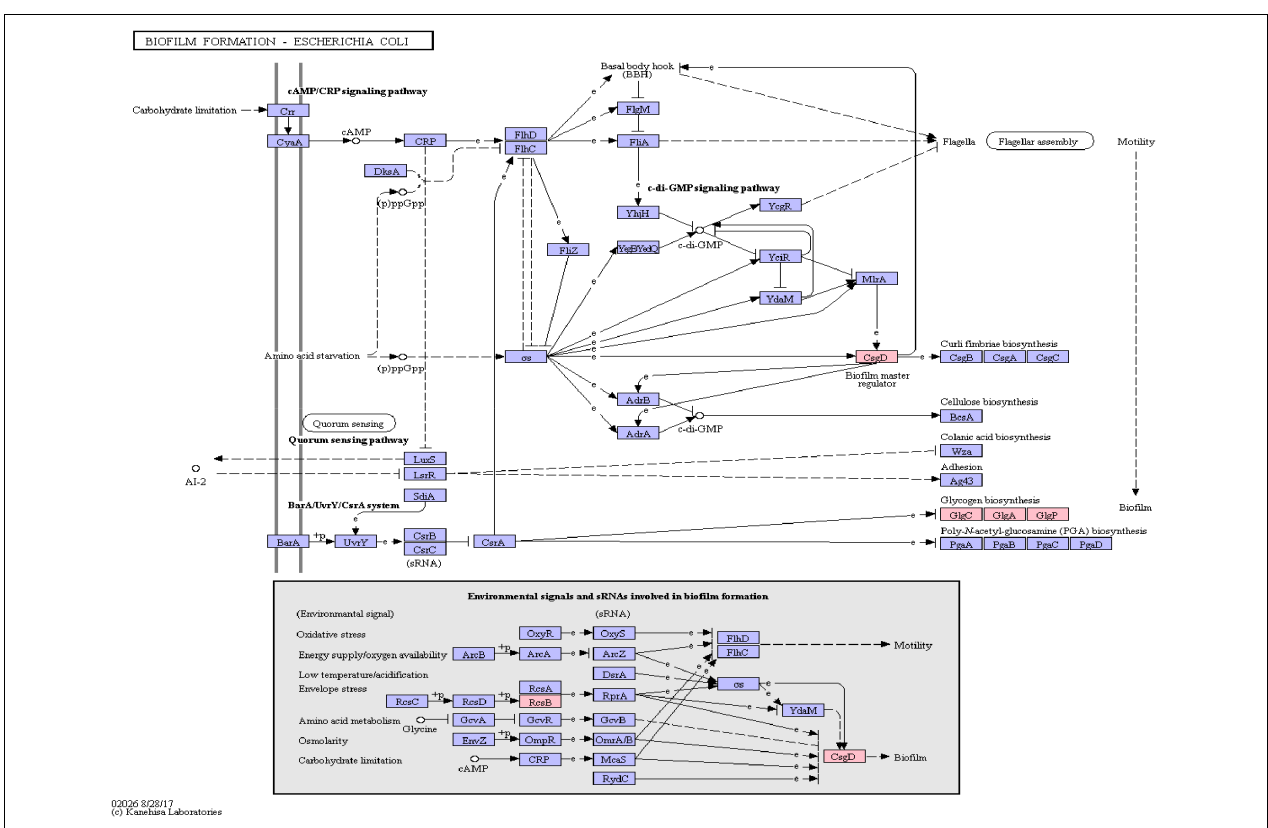
FIGURE 6 | Biofilm Formation Pathway using KEGG pathway mapping for E. coli . Proteins encoded by bacterial genome regions that revealed miRNA target matches are colored in